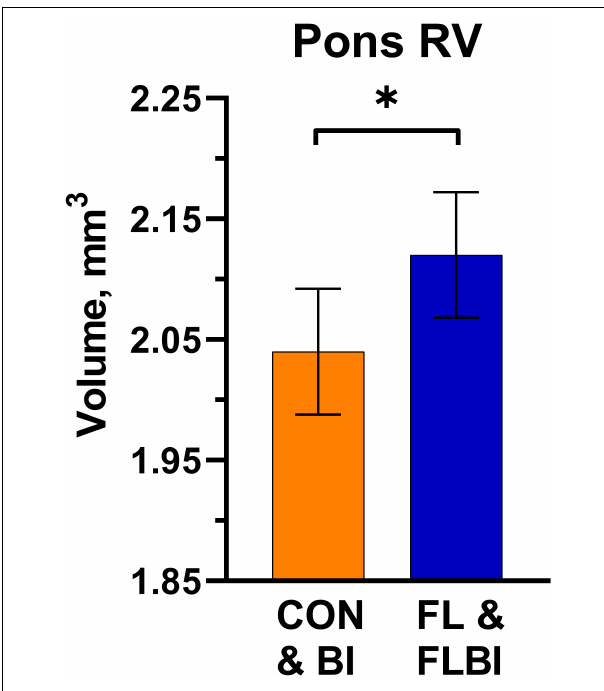
FIGURE 1 | Pons relative volume results. Differences ( P = 0.046) in relative volume for the Pons brain region were observed between the groups supplemented with 2 (cid:48) -FL (FL and FLBI) compared with those that did not receive 2 (cid:48) -FL supplementation (CON and BI). Groups receiving 2 (cid:48) -FL had larger relative volumes for this brain region. *Asterisk denotes a significant difference between group means ( P < 0.05). CON, group receiving control diet; FL, group receiving control diet + 1.0 g/L 2 (cid:48) fucosyllactose; BI, group receiving control diet + 10 9 CFU Bi-26/day; FLBI, group receiving control